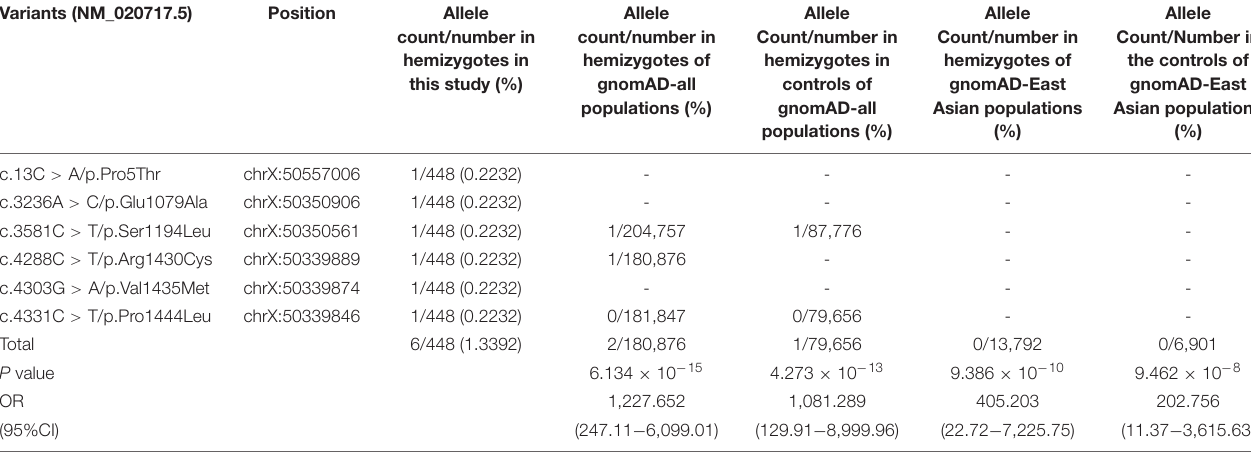
TABLE 2 | Analysis of the aggregate frequency of SHROOM4 variants identified in this study.